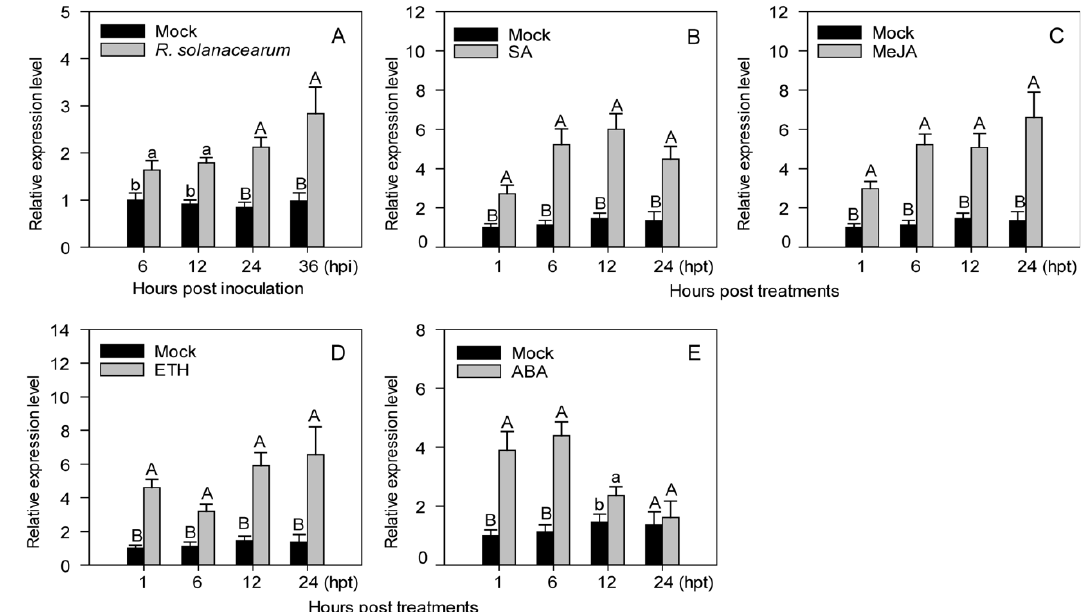
Figure 2 . Real-time qRT-PCR analysis for relative transcript levels of CaASHH3 in pepper leaves subjected to Ralstonia solanacearum and exogenous application of phytohormones. ( A ) qRT-PCR analysis of relative transcriptional expression levels of CaASHH3 in pepper leaves at various time intervals after treatment with virulent R. solanacearum strain ‘ FJC100301 ’ . ( B – E ) qRT-PCR analysis of relative transcriptional expression levels of CaASHH3 at various time intervals after treatment with 1 mM SA ( B ), 100 µM MeJA ( C ), 100 µM ETH ( D ), and 100 µM ABA ( E ). The relative transcriptional expression levels in R. solanacearum -treated and phytohormone-treated leaves were compared with mock plants (which normalized to a relative transcriptional expression level of 1). Error bars indicate the standard error. Different letters above the bars indicate significant differences between means from four biological replicates based on Fisher’s protected LSD test: uppercase letters represent p < 0.01; lower case letters represent p < 0.05.